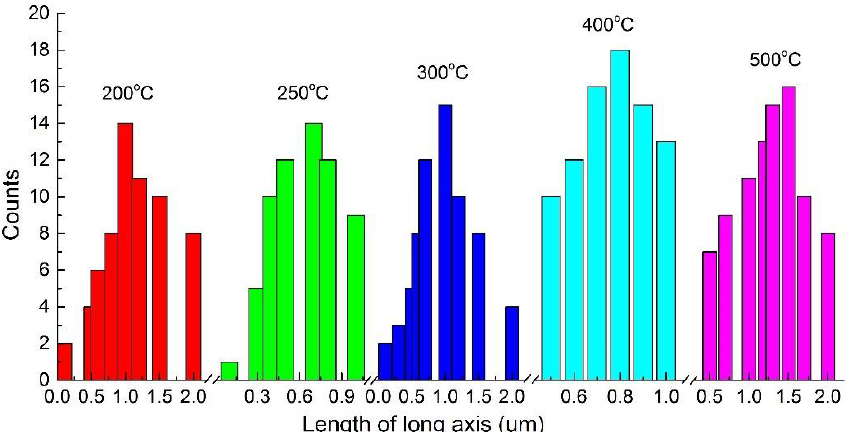
Figure 6. Statistical histograms of long-axis sizes for zirconia micro-nanoflakes (ZrO 2 ) synthesized at 250–500 °C.